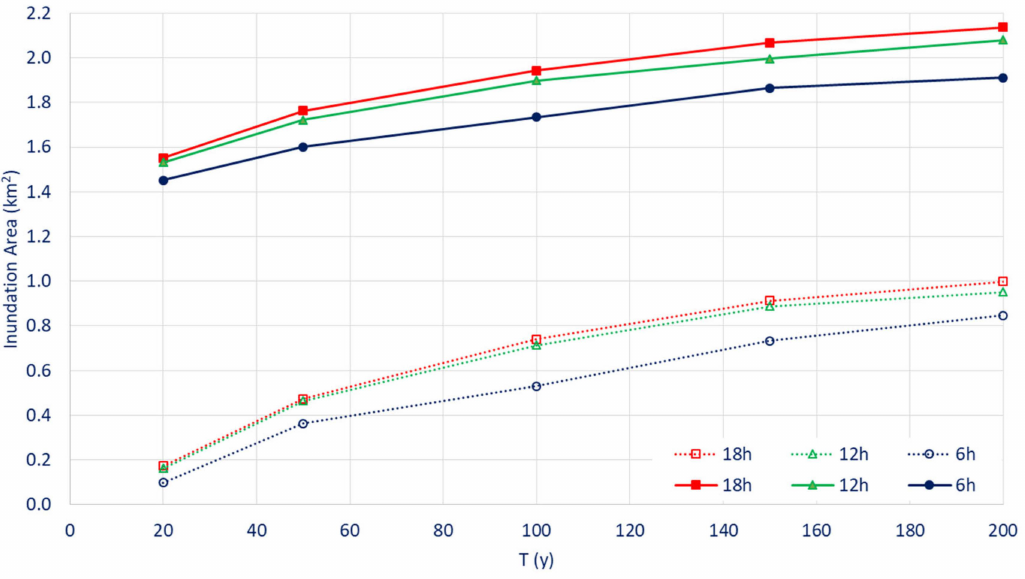
Figure 3. Calculated inundation areas for all scenarios (dotted lines refer to scenarios with flood protection works).